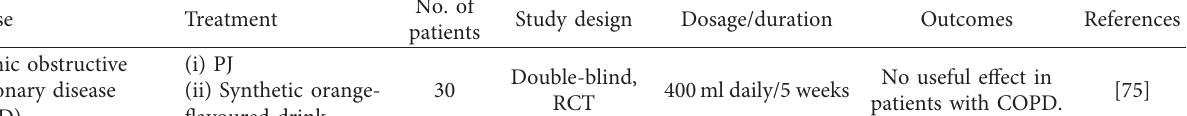
Table 4: Summary of clinical trials using Punica granatum (pomegranate) in other disorders.